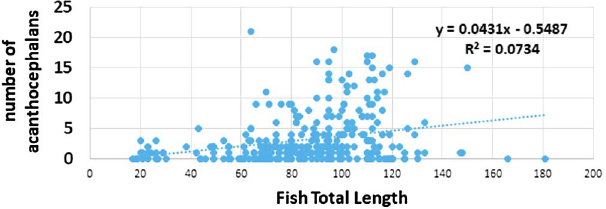
Figure 10. Abundance of infection of Coptodon guineensis at Sebkha Imlili by acanthocephalan Acanthogyrus ( Acanthosentis ) cf. tilapiae according to fi sh total length. Infection occurred in fi sh as small as 20 mm. Larger fi sh were more often infected than smaller fi sh.